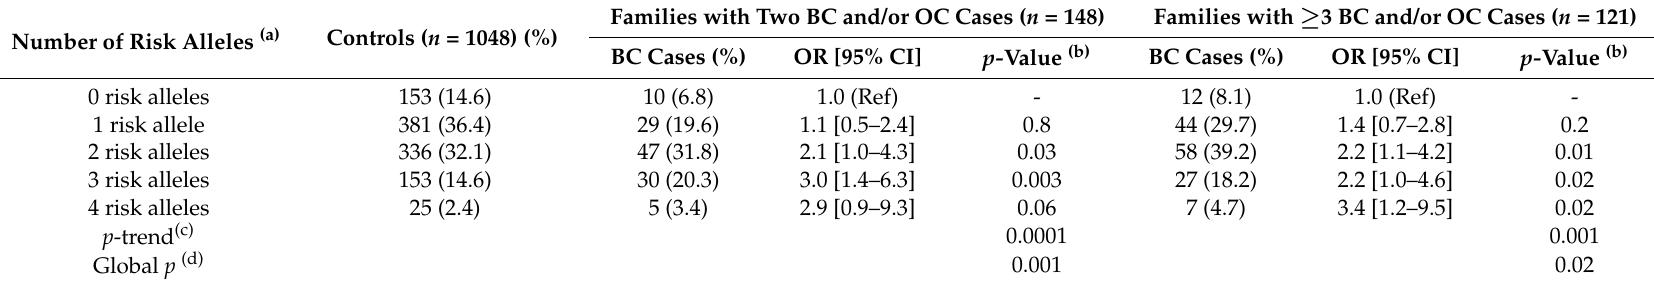
Table 5. Combined effects of rs38033662 ( TOX3 ) and rs4541843 (pri-miR-182) on the risk of breast cancer according the number of BC cases in the